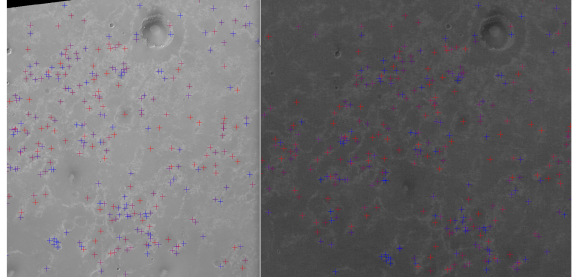
Figure 6. an example of MSA-SIFT tie-points from MER-B CTX ORI (left) and HRSC ORI (right), showing increasing uncertainty value from blue to red.